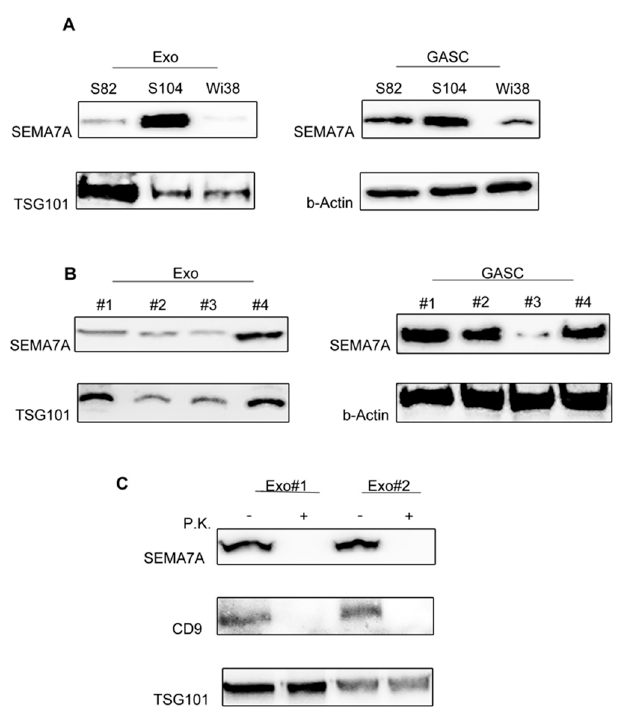
Figure 2. SEMA7A (Semaphorin7A) is present on the surface of Glioma Associated Stem Cells (GASC)-derived exosomes. ( A ) Western blotting showing the expression of SEMA7A in the same exosomal preparations used for the proteomic study (Exo_S82 and Exo_S104, left panel) and in the matched producing cells (GASC_S82 and GASC_S104, right panel). As healthy control, SEMA7A expression was evaluated both in Wi38 cells and in Wi38-derived exosomes (Exo-Wi38). ( B ) SEMA7A expression was assessed in 4 different GASC cell lines (GASC#1, GASC#2, GASC#3 and GASC#4) and in the respective derived exosome preparations (Exo#1, Exo#2, Exo#3 and Exo#4). Membranes were hybridised with anti-TSG101 (Tumour Susceptibility Gene 1) and beta-Actin to show the reliability of exosomes and cell lysates respectively. ( C ) Western blot analysis for SEMA7A, CD9 and TSG101 in Exo#1 and Exo#2 preparations either untreated ( − ) or subjected to proteinase K treatment (P.K., +).